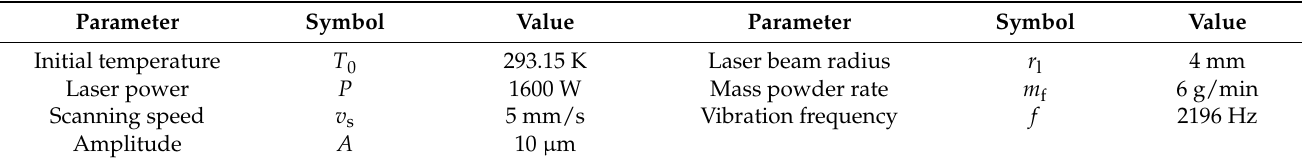
Table 3. Laser process parameters used in the numerical